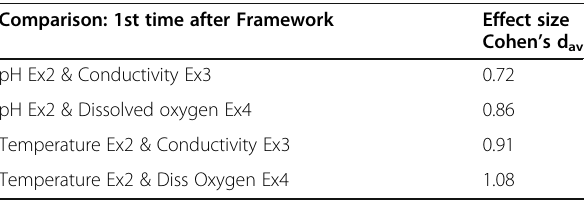
Table 7 Student Science Ideas - first time after introduction of Claim, Evidence, Reasoning n = 52